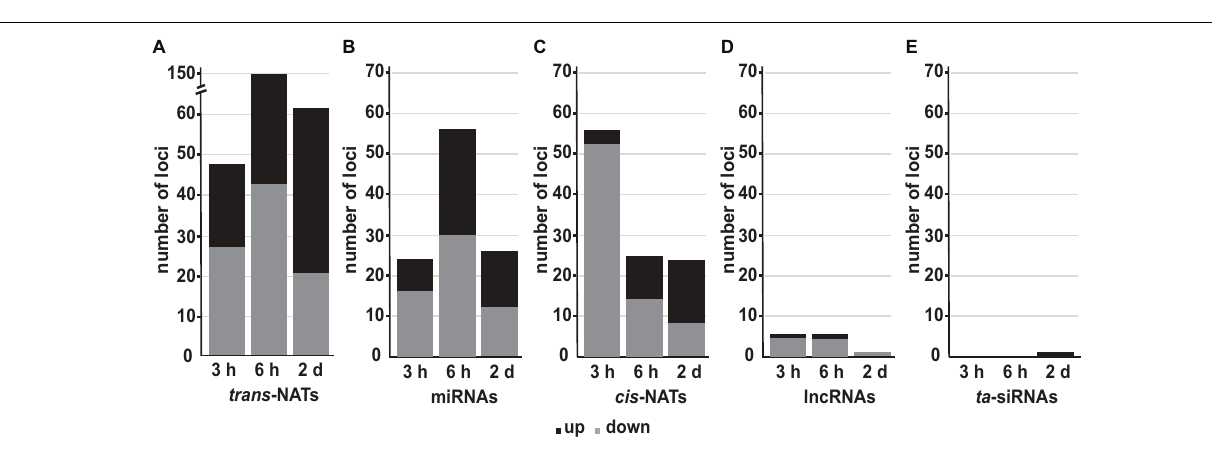
FIGURE 2 | Number of detected sRNAs belonging to different sRNA classes during high light acclimation. The number of up- (black) and downregulated (gray) sRNAs from trans -NATs (A) , miRNAs (B) , cis -NATs (C) , lncRNAs (D) , and ta-siRNAs (E) in response to high light treatment after 3 h, 6 h, and 2 days (FC ≥ 2 and ≤− 2, Benjamini-Hochberg corrected p -value ≤